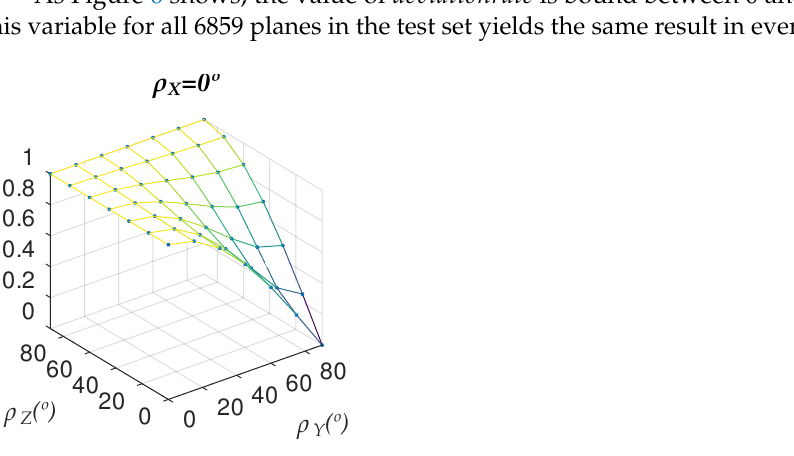
Figure 5. Deviationrate as a function of ρ Y and ρ Z and for ρ X = 0 ◦